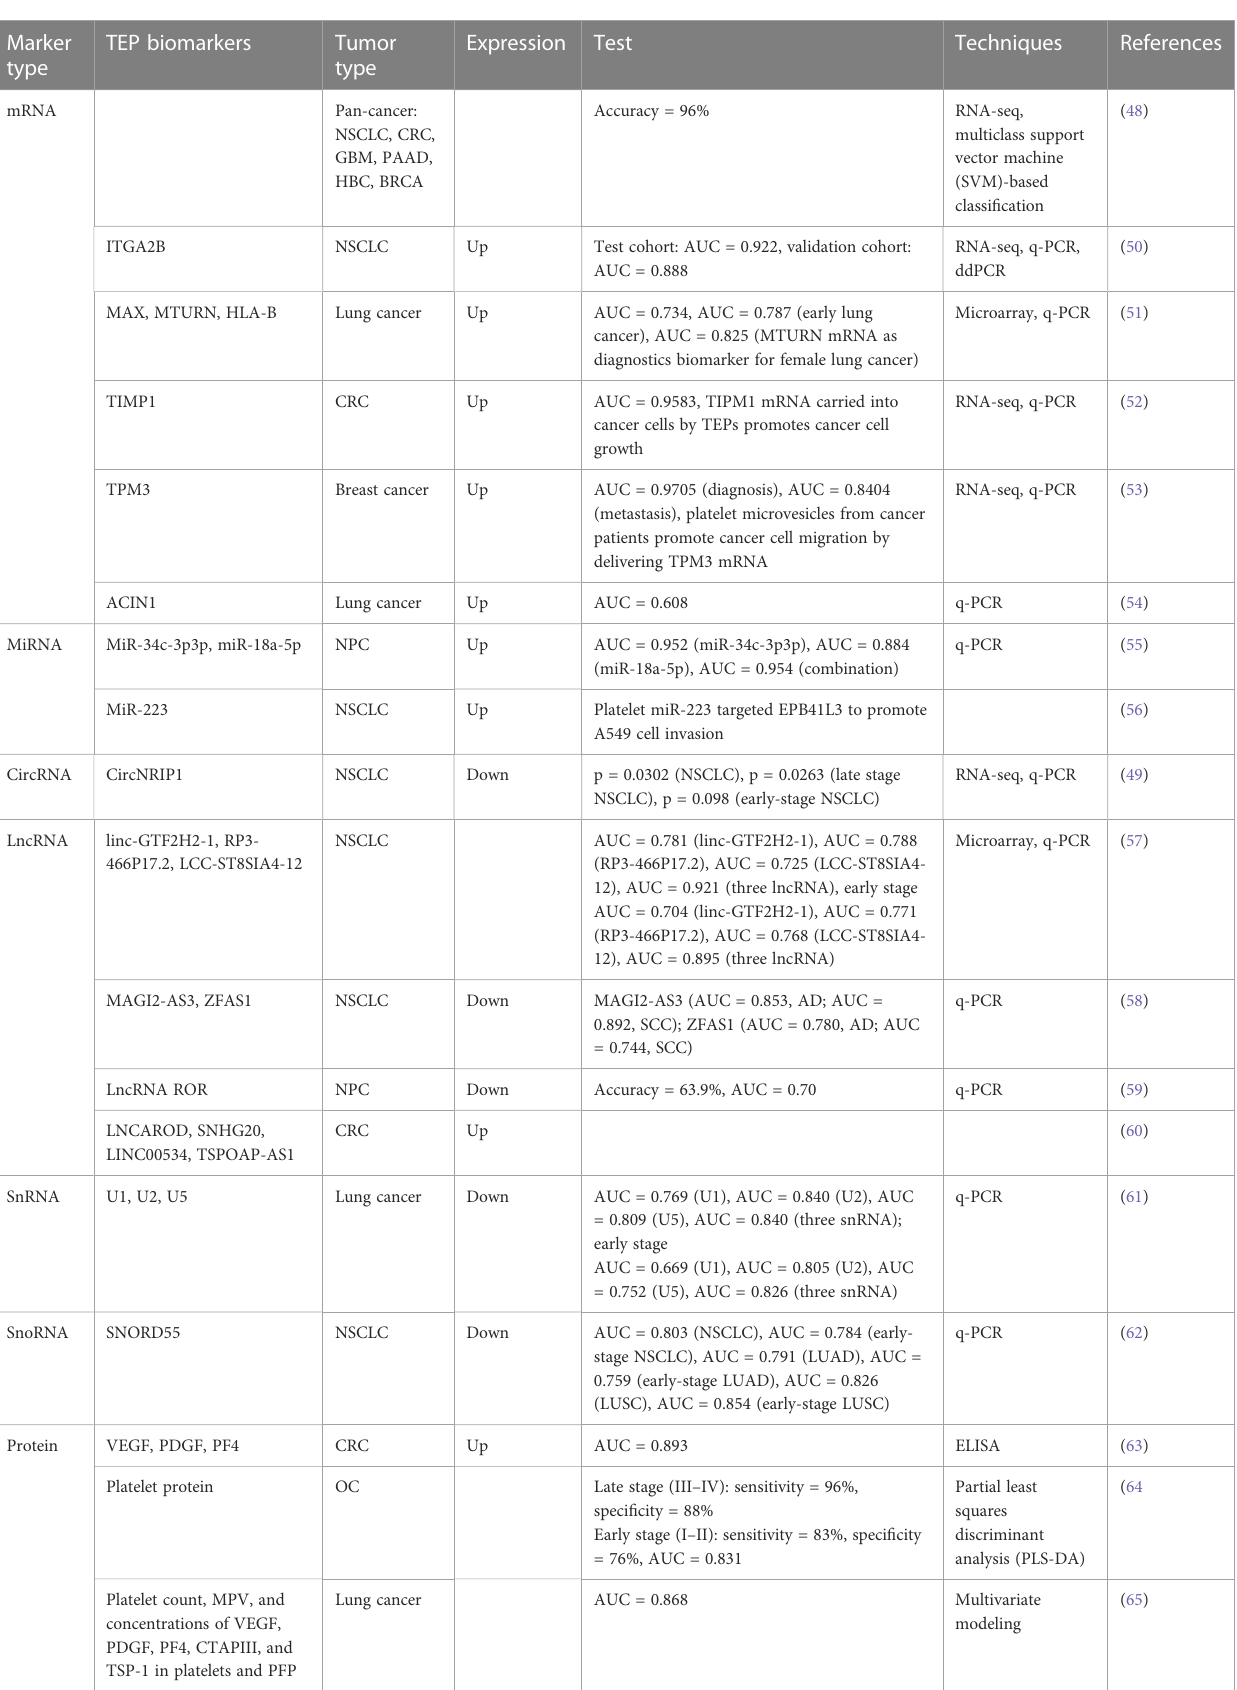
TABLE 1 Role of RNA molecules and proteins in cancer diagnosis in